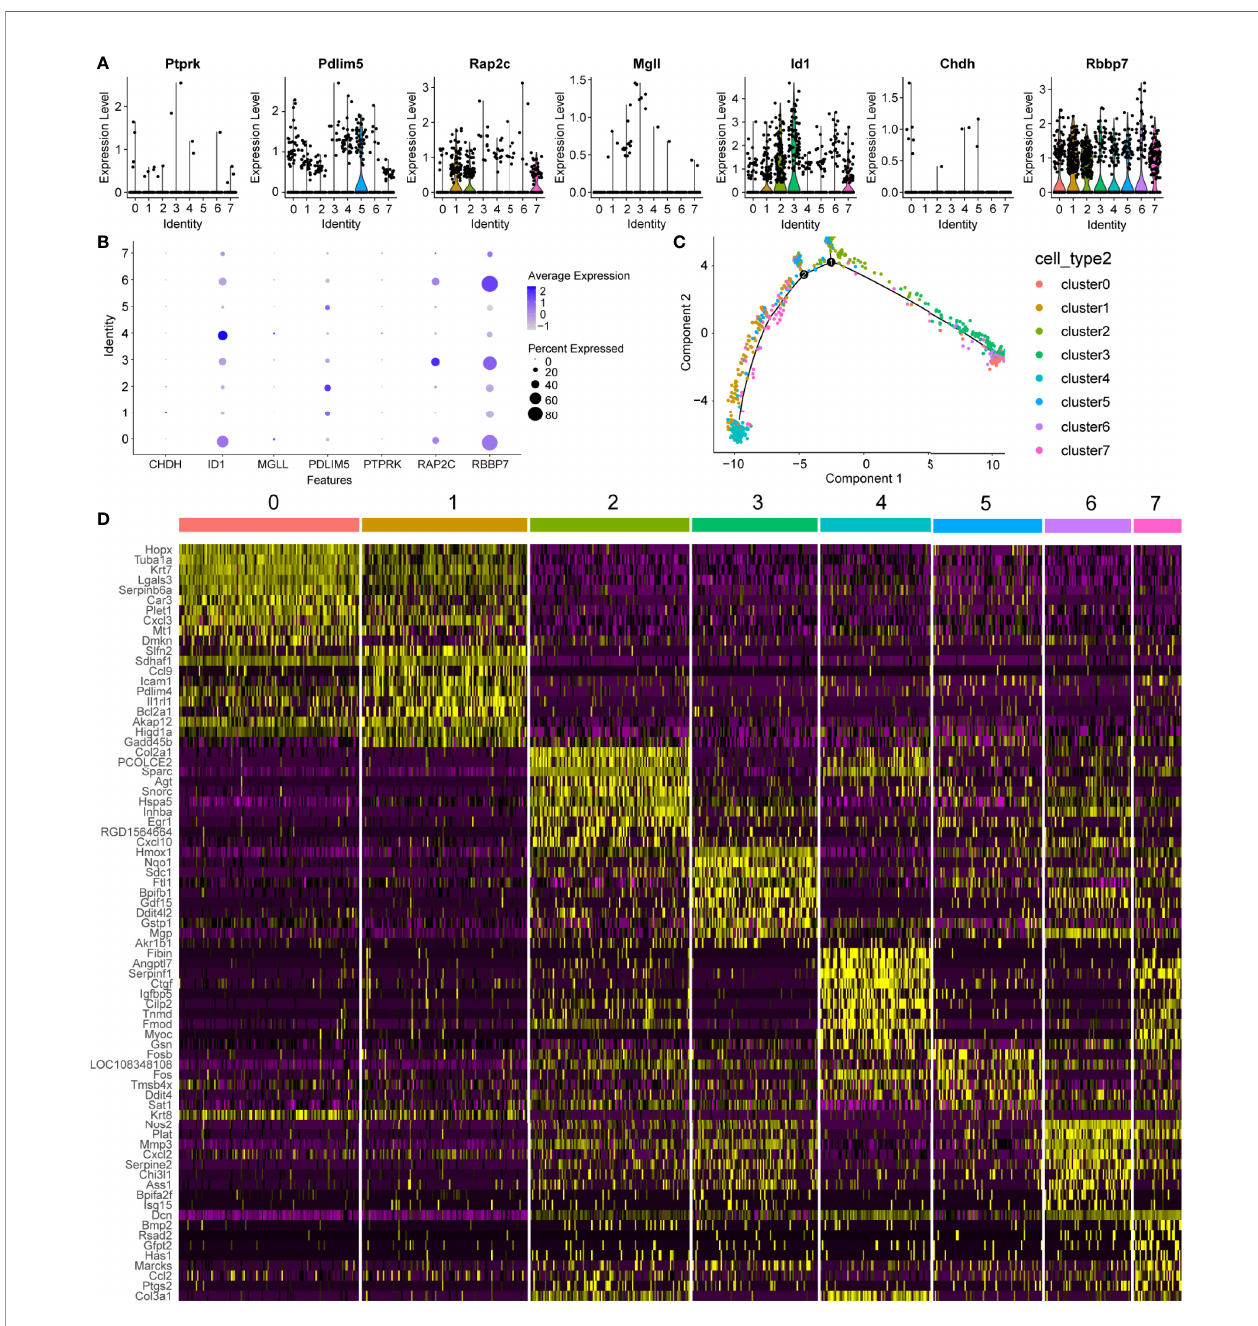
FIGURE 5 | Clustering of nucleus pulposus (NP) cells, revealing key gene expression patterns. (A, B) The expression pattern of key genes in each NP cluster is shown in the violin maps and dot plot. Clusters 1, 2, 4, and 5 refer to each NP subcluster. In the dot plot, the average expression of each cluster is represented by a color gradient, in which lower expression is represented by a lighter color and higher expression is represented by darker color. The percentage of cells is indicated by dot size. (C) Cell trajectory analysis of the clusters, including NP cells. Noted that NP cells in cluster 5 are mainly located in the root, while other cells in clusters are distributed in branches. (D) The heatmap shows the marker genes in each